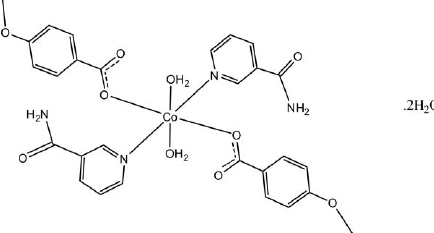
Data collection Bruker Kappa APEXII CCD area- detector diffractometer Absorption correction: multi-scan ( SADABS ; Bruker, 2005) T min = 0.799, T max = 0.856